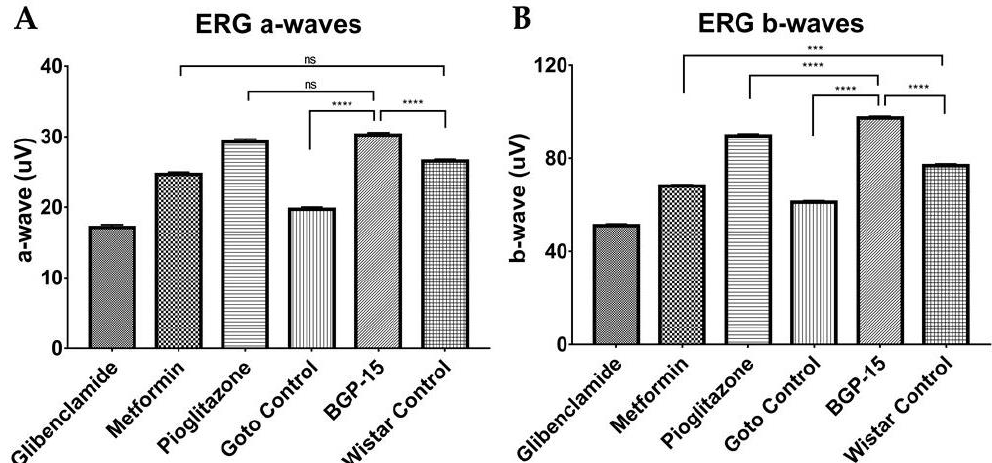
Figure 9. Results of electroretinographical (ERG) measurements. ( A ) Group means of a-waves; ( B ) Group means of b-waves. All data are presented as group means± standard error of the mean (SEM). n = 6 animals in each group. In both inserts all unmarked comparisons (between any two groups) are **** p < 0.0001. *** p < 0.001; ns = non-significant. Statistical analysis was done using GraphPad Prism: